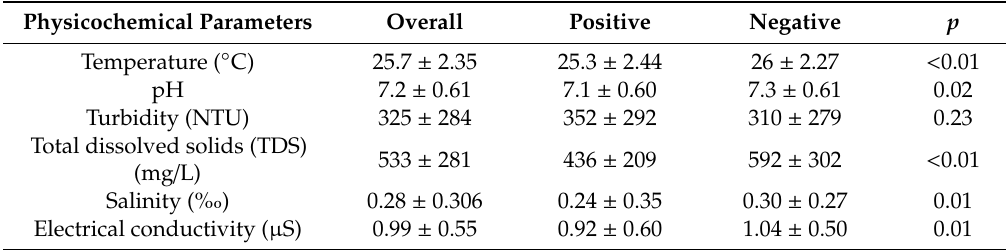
Table 1. Physicochemical parameters (mean, standard deviation, and p -value) of pathogenic Leptospira positive and negative samples measured in the water samples collected in Pau da